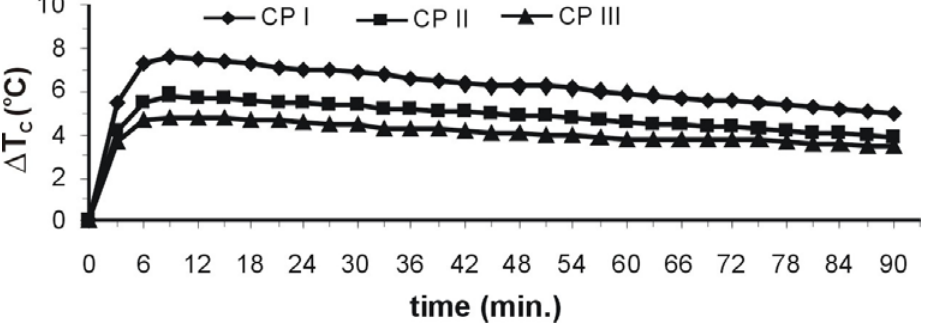
Figure 3. The variation of the temperature at the inlet and outlet of the condenser along the experiment according to the circulation pump flow rates at fixed waste water temperature of 30 °C.